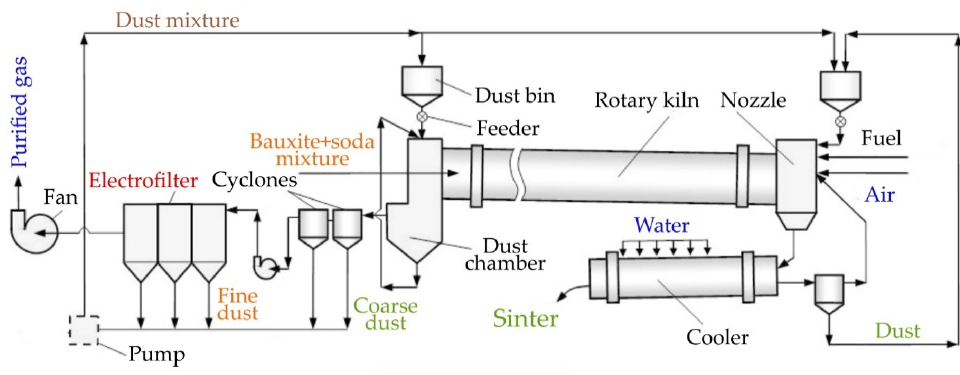
Figure 1. Flow chart of the sintering process on the RUSAL-Kamensk-Uralsky alumina refinery.